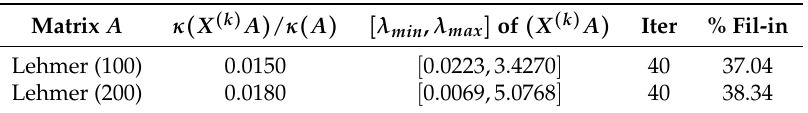
Table 7. Performance of MinCos applied to the Lehmer matrix, for different values of n and a maximum of 40 iterations, when (cid:101) = 0.01, thr = 0.06, and l fil =